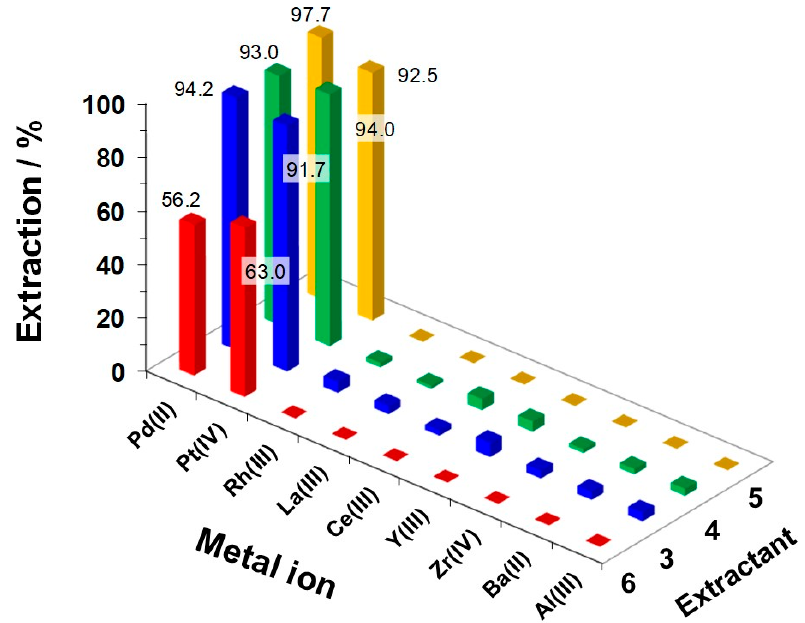
Figure 2. Liquid-liquid extraction from the 25 times-diluted leach liquors of automotive catalysts by three macrocylic extractants 3 – 5 and acyclic compound 6 . Contact time = 60 min; [ 3 – 5 ] = 1.0 mM in CHCl 3 ; [ 6 ] = 4.0 mM in CHCl 3 ; metal ions = Pd(II), Pt(IV), Rh(III), La(III), Ce(III), Y(III), Zr(IV), Ba(II), and Al(III); pH = 1.22 (~0.06 M HCl); temperature = 20 ± 1 °C.